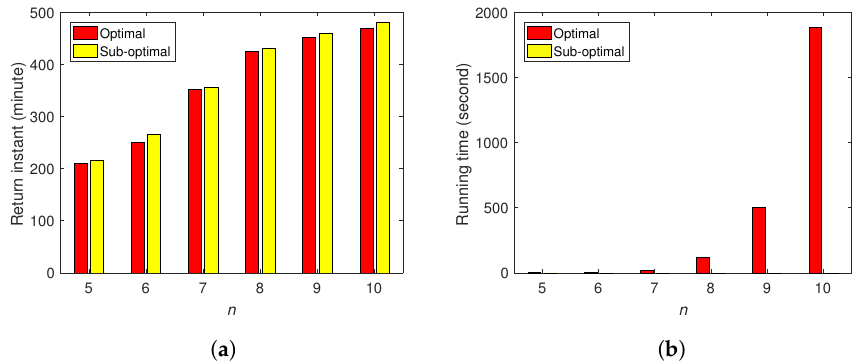
Figure 7. ( a ) Return instants for different n . ( b ) Algorithm running time. The results of the sub-optimal algorithm are all lower than 0.1 s.